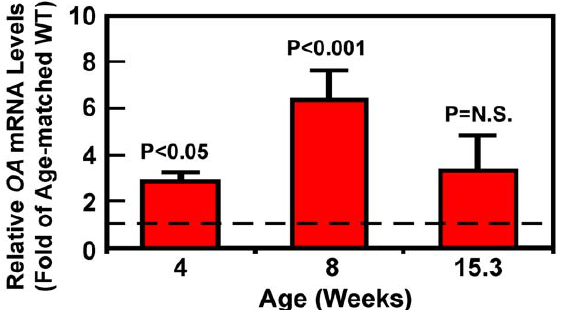
Figure 3. Age effect on the relative overexpression levels of OA mRNA in femurs of female OA -Tg mice. Total RNA was isolated from femurs of female OA -Tg mice of age of 4-, 8-, and 15.3-week-old and corresponding WT littermates (3–5 mice per group) and cDNA